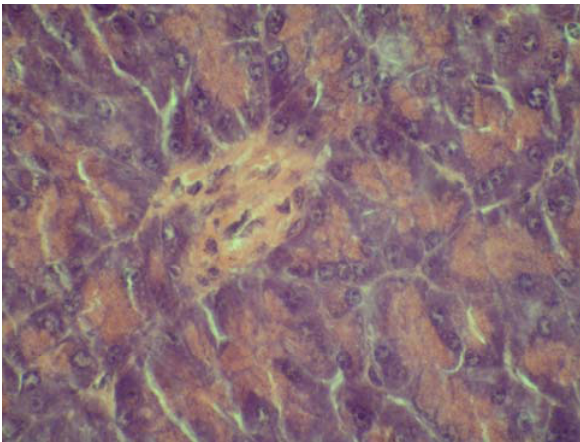
Figure 3. Microphotograph of the pancreas of alloxan-treated mice (HE 600×). Rudimental reaction to the destroyed pancreatic islet.